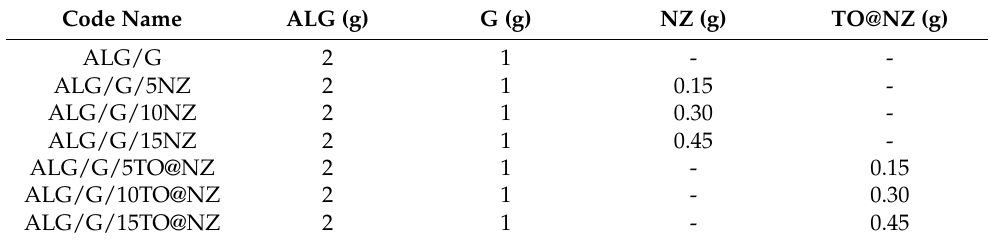
Table 5. Code names and amounts of ALG, G, NZ and TO@NZ used for the preparation of